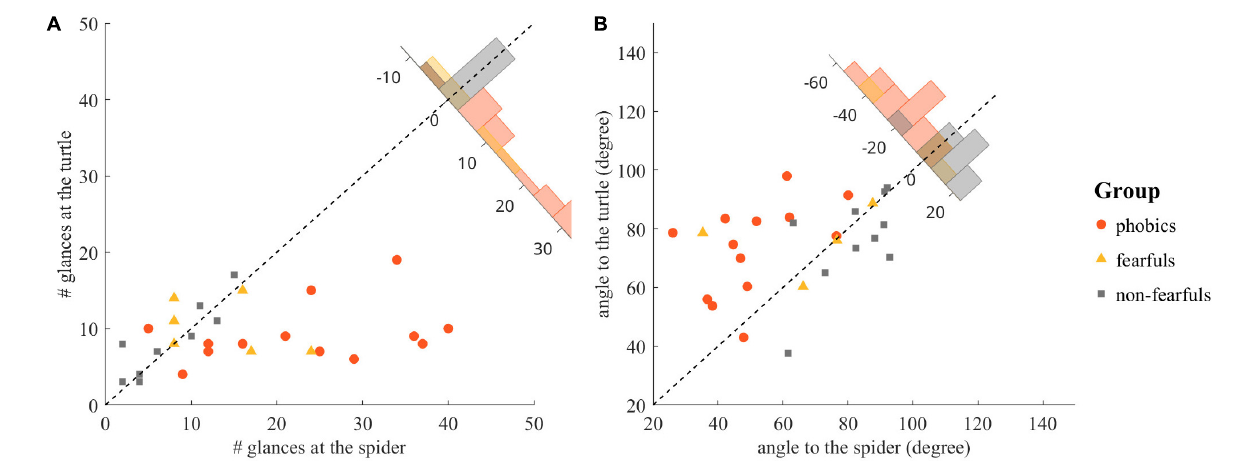
FIGURE 4 | Detailed analyses of the Fishing task: (A) Comparison of the number of glances at the spider and the number of glances at the turtle, including the histogram of individual differences in the upper right corner. (B) Comparison of the angle between the chest front and the spider and the angle between the chest front and the turtle, including the histogram of individual differences in the upper right corner. The angle was 0 if the chest front was facing the animal and 180 when it was facing away from the animal.